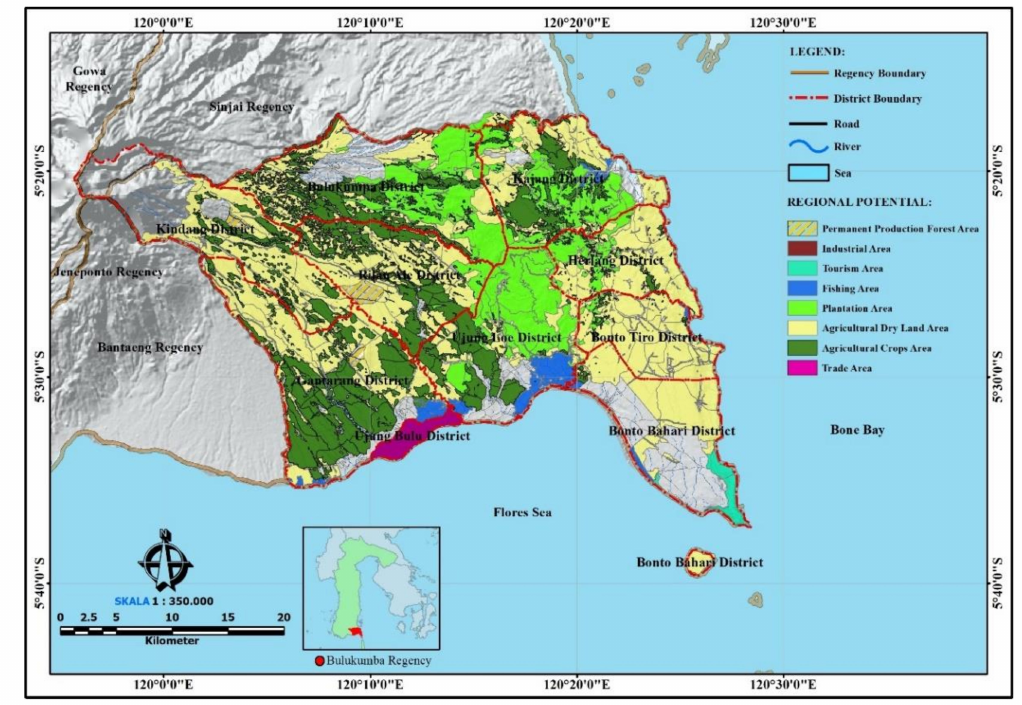
Figure 2. Administrative map and regional potential. Source: Authors; Map ©